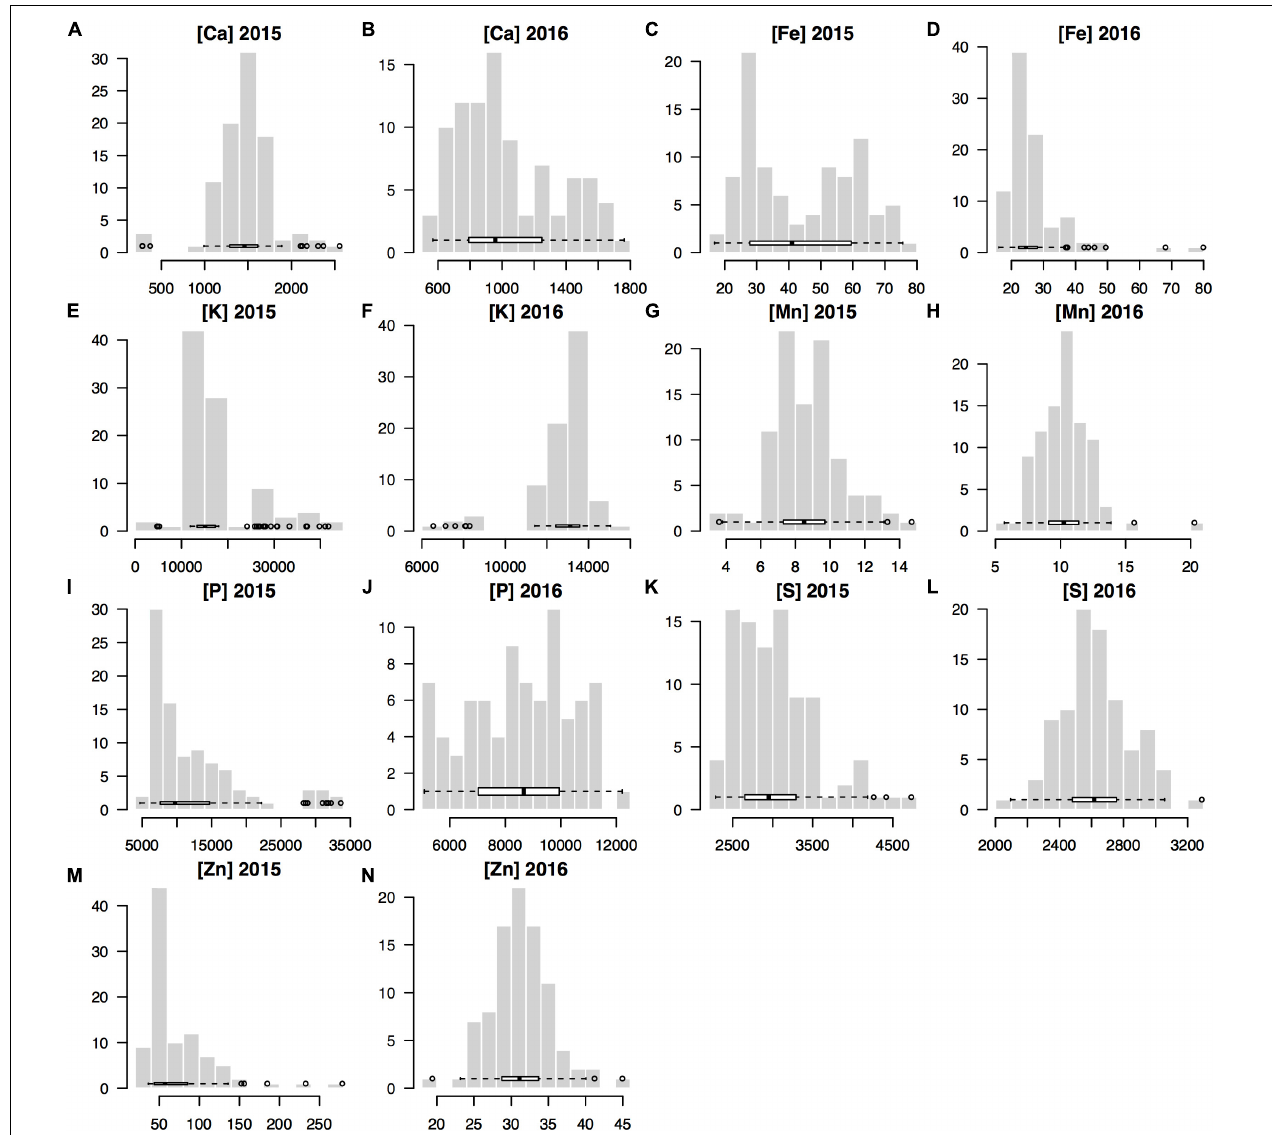
FIGURE 1 | Histograms for the concentrations of seven minerals measured for the seed produced by 95 mung bean ( Vigna radiata ) genotypes harvested across 2 years (2015 and 2016) used in genome wide association studies (GWAS) for Ca, calcium (A,B) ; Fe, iron (C,D) ; K, potassium (E,F) ; Mn, manganes (G,H) ; P, phosphorus (I,J) ; S, sulfur (K,L) ; and Zn, zinc (M,N)